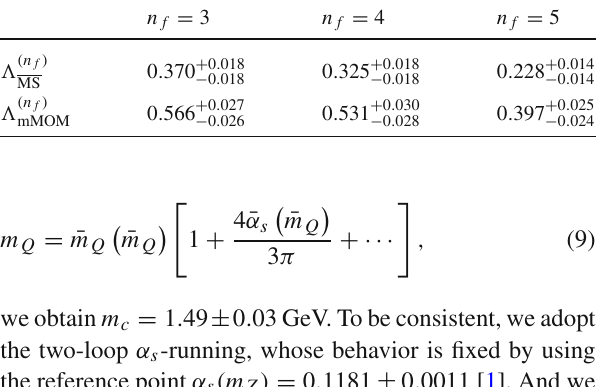
Table 1 Asymptotic scales under the MS-scheme and the mMOM- scheme with different flavor number n f n f = 3